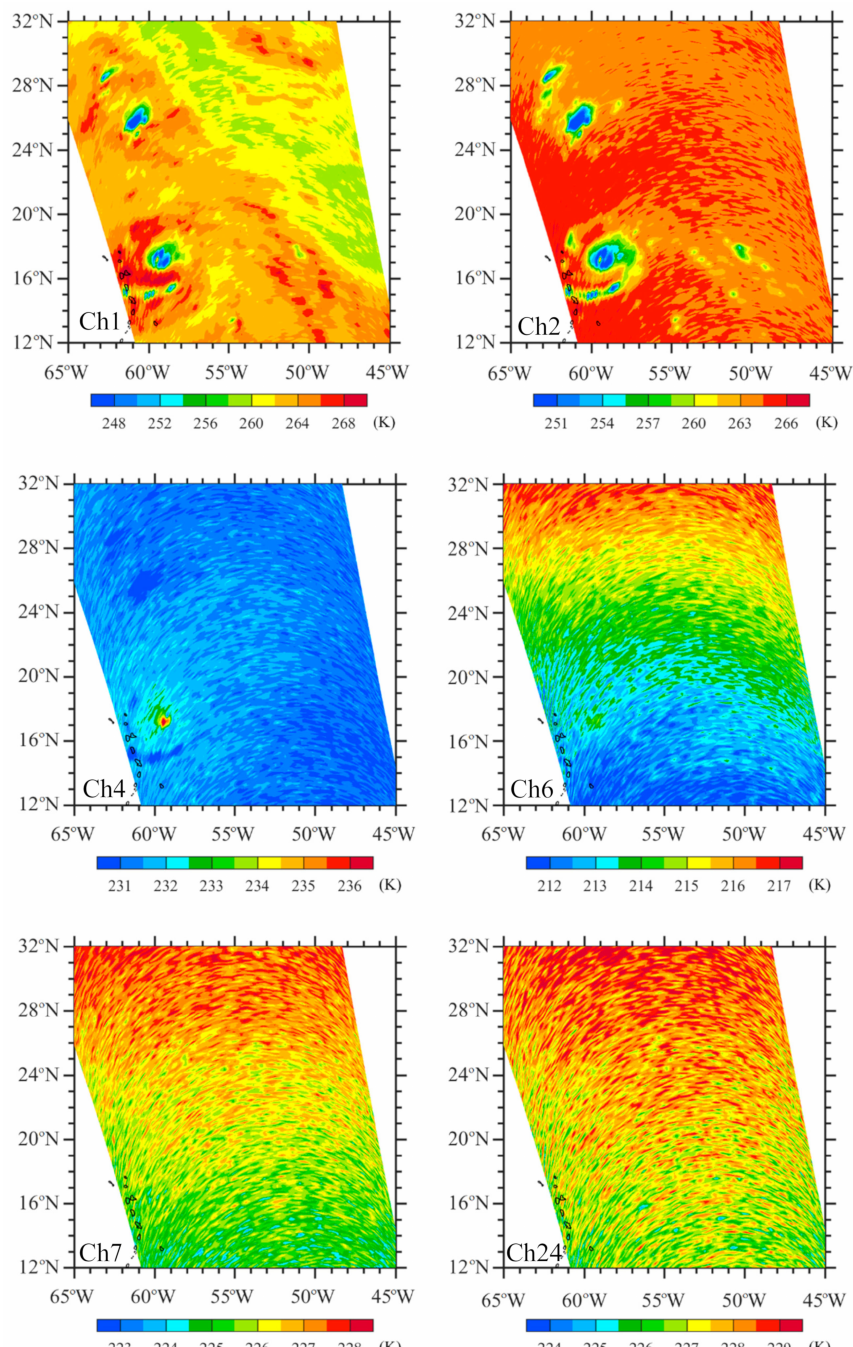
Figure 10. TB observations after noise reduction for channels 1, 2, 4, 6–7, and 24 on 5 September 2017. Hurricane Irma was located around 17.0 ◦ N, 59.7 ◦